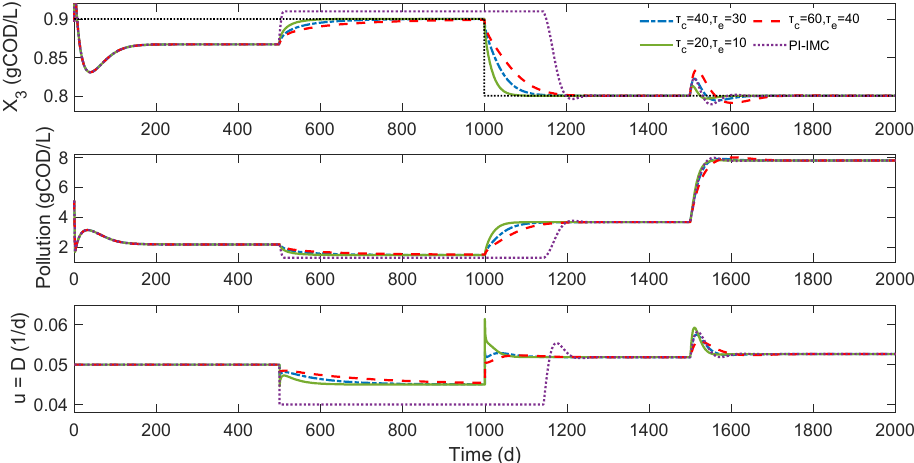
Figure 4. Closed-loop performance of the MEC controller for the methanogenic biomass concentration control problem.